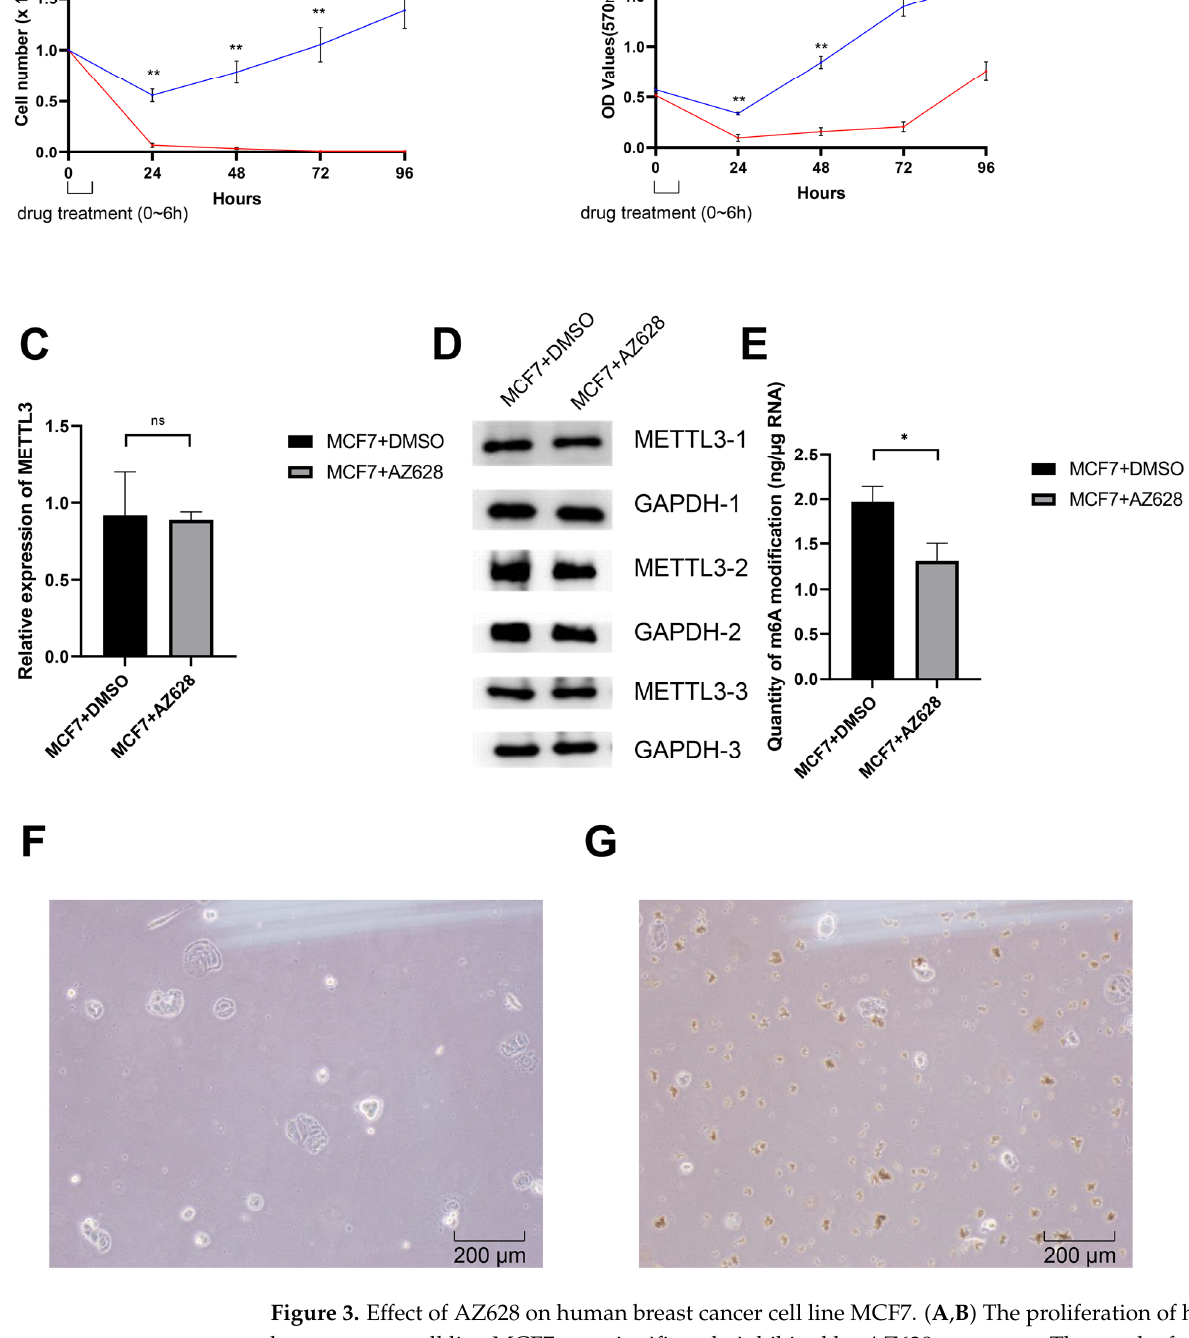
Figure 3. Effect of AZ628 on human breast cancer cell line MCF7. ( A , B ) The proliferation of human breast cancer cell line MCF7 was significantly inhibited by AZ628 treatment. The results from the cell count assay ( A ) and the MTT assay ( B ) are shown. Data represented the mean ± SEM from five independent experiments, t -test, ** p < 0.01. Some SEM values in the drug-treated experimental group that are too small to be shown are specified here: ( A ) 24 h. 0.021; 48 h, 0.013; 72 h, 0.001; 96 h, 0.001; ( B ) 24 h. 0.035; 48 h, 0.038; 72 h, 0.047; 96 h, 0.094. ( C , D ) The protein expression of METTL3 in the MCF7 cell line was not significantly affected by drug treatment, t -test, none significance (ns). The summary of Western blot grey values as the mean ± SEM from three independent experiments ( C ) and the representative Western blot result ( D ) are shown. ( E ) The RNA m6A modification level